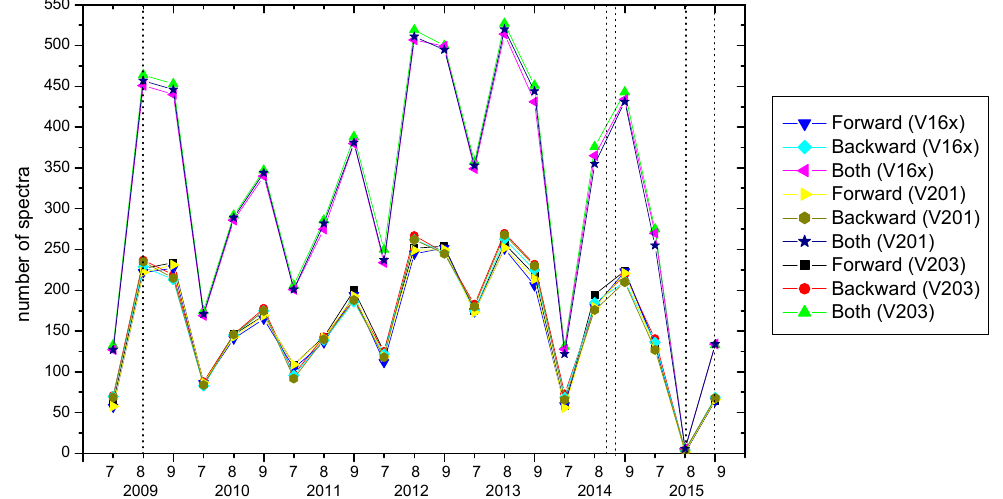
Figure 5. The number of TIR spectra considered for each version (V16x, V201 and V203) as a function of the year/month and OPD direction (0 = forward, 1 = backward, 2 = both). Vertical dashed lines correspond to the platform or instrument events introduced in Table 1.